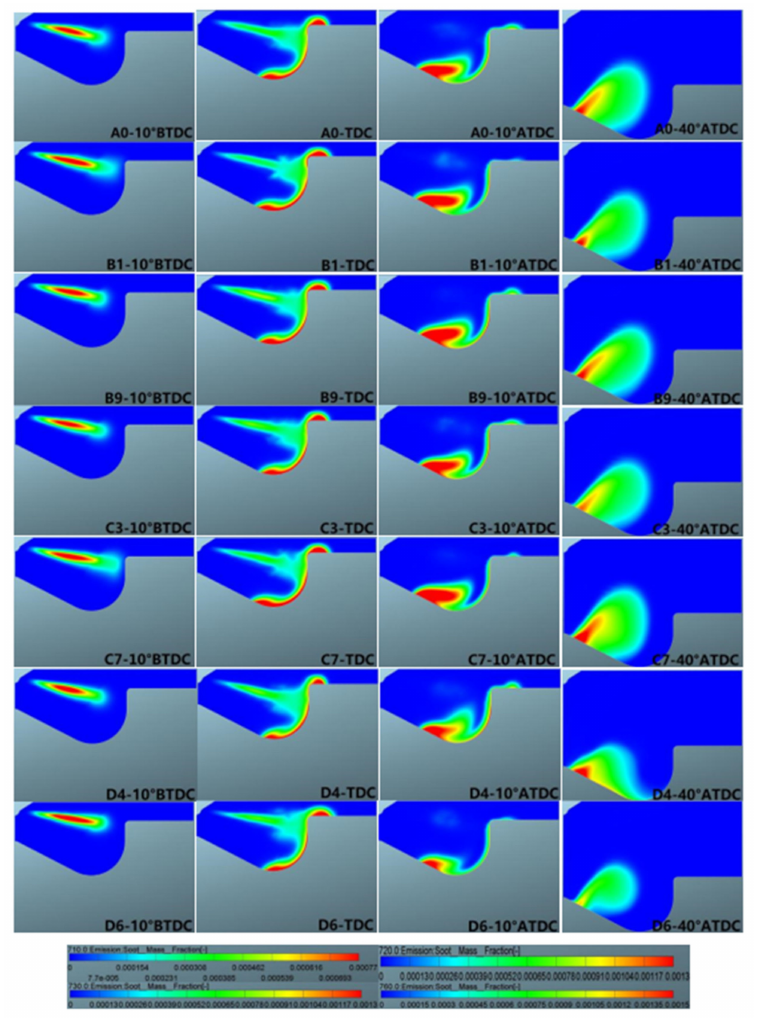
Figure 44. Map of the Soot mass fraction